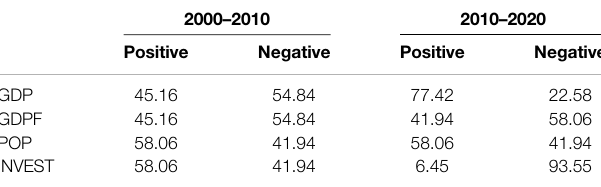
TABLE 6 | Proportions of the cities with different types of coef fi cients